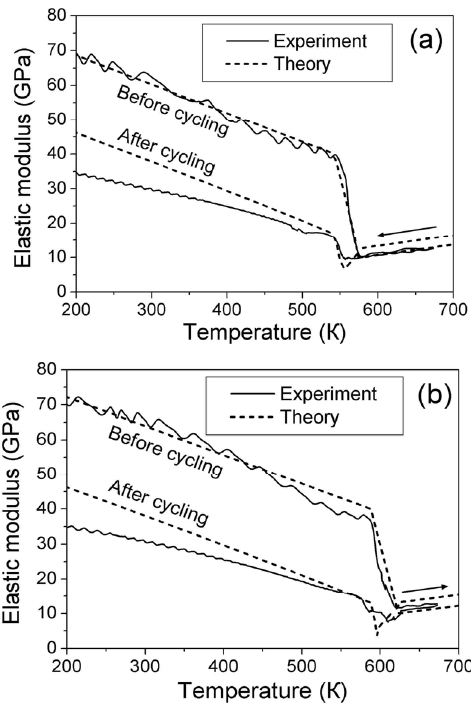
Figure 8. ( a ) An influence of the thermomechanical cycling on the elastic modulus measured on cooling of Sample 1. ( b ) The influence of thermomechanical cycling on the elastic modulus measured on heating of Sample 1. The dashed lines show the theoretical temperature dependencies of elastic modulus that are derived in Section